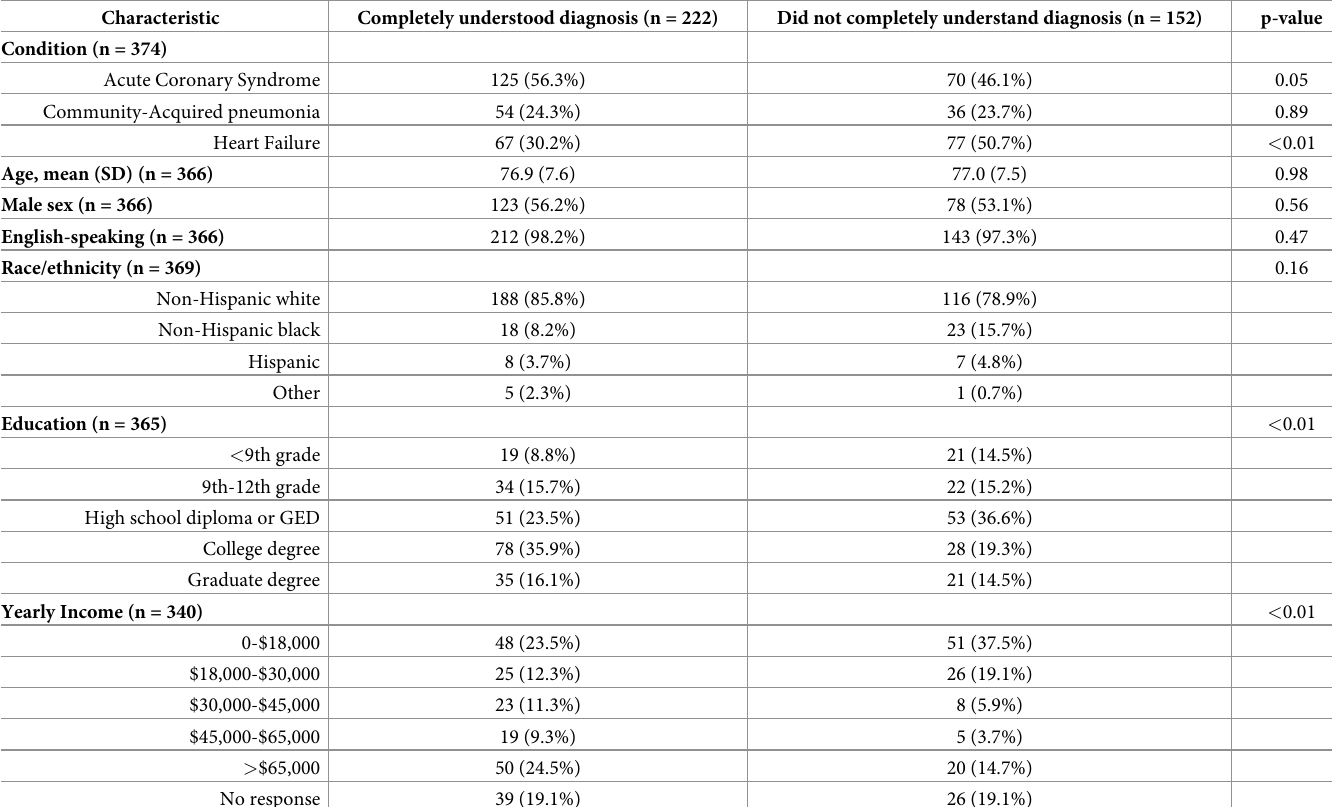
Table 1. Baseline characteristics of the study cohort (n =